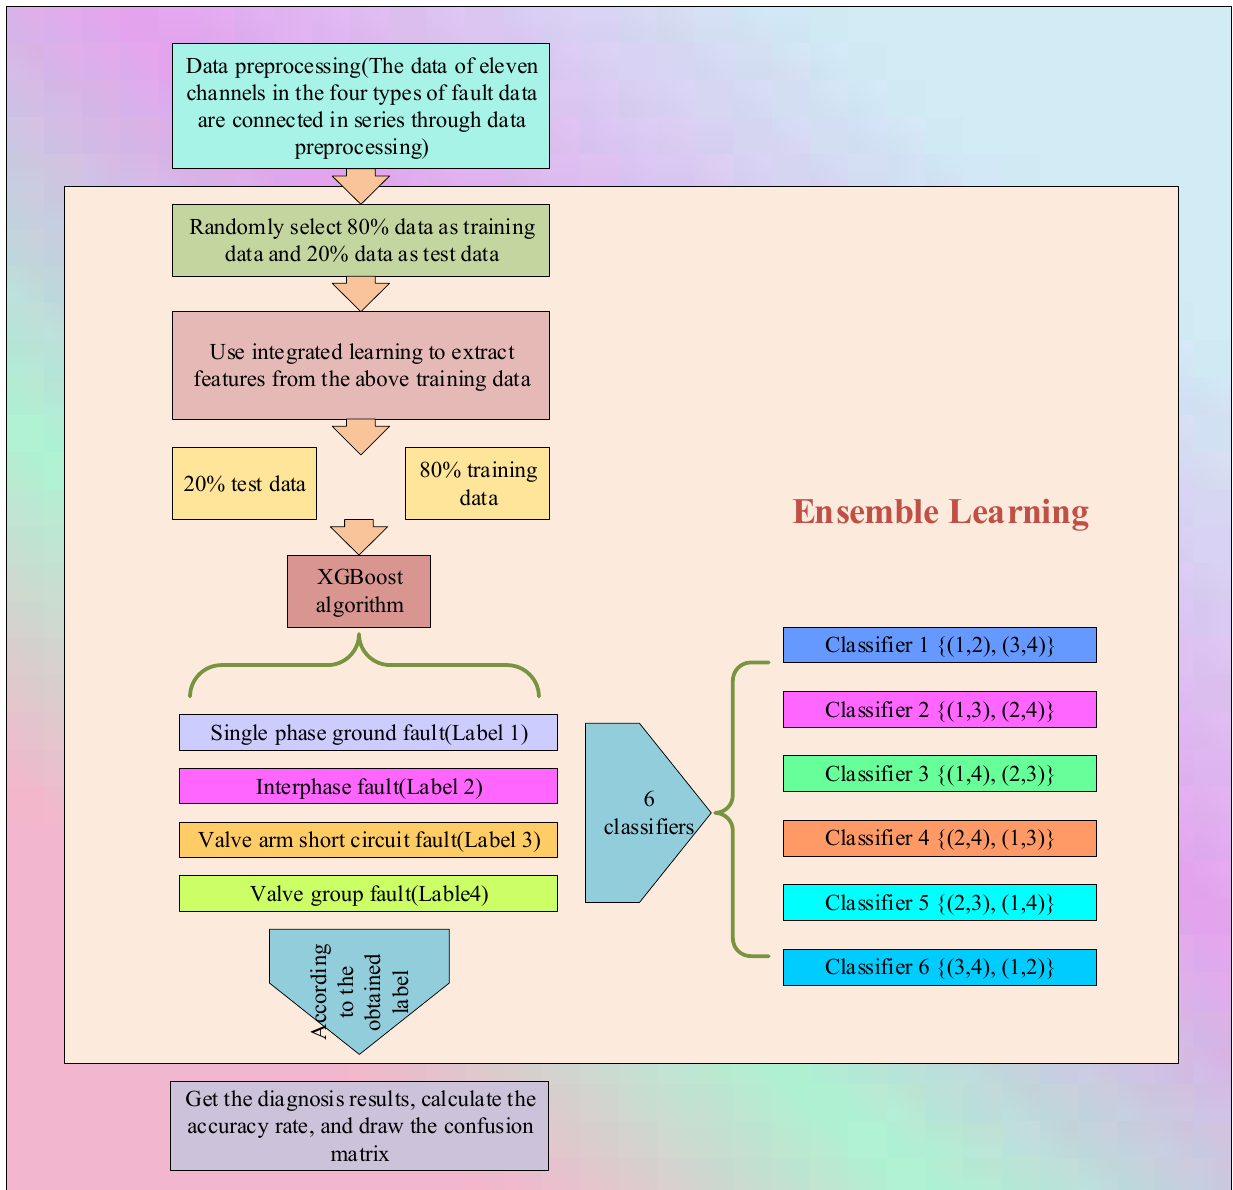
Figure 5. Flow chart of HVDC fault classification based on XGBoost. Table 1. Fault types of fault points of a substation in a southwest power grid in China.